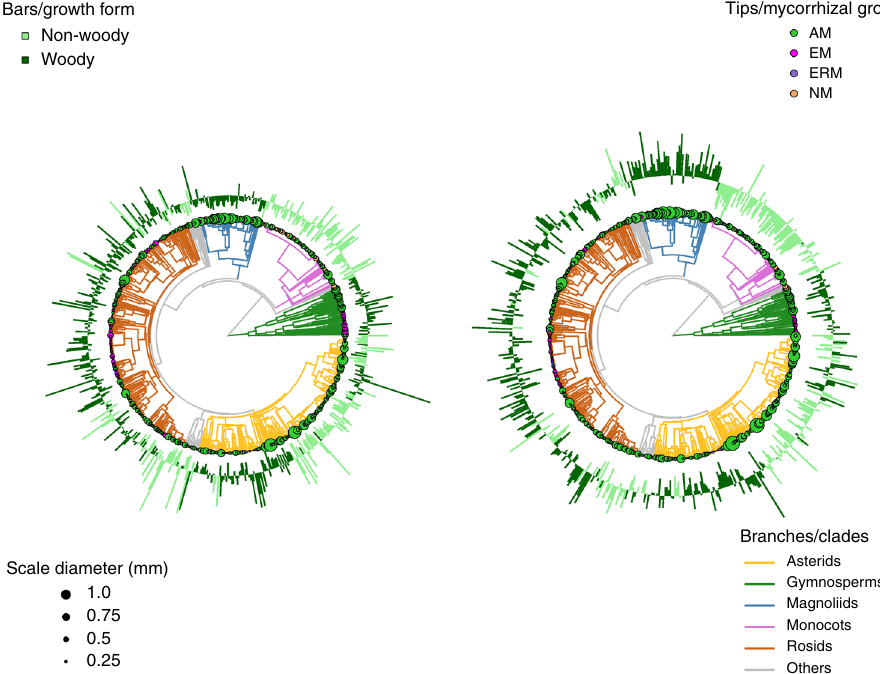
Fig. 3 Variation of root traits with plant phylogeny. Variation in root diameter, root tissue density (RTD, left panel) and root N concentration (RN, right panel) with plant phylogeny, growth form and mycorrhizal type. The size of the circles at the tip of the phylogenetic tree is proportional to root diameter. Bars represent standardized values for RTD and RNC, with outward and inward bars representing values above and below the mean, respectively, and colors representing different growth forms. Branch colors in both phylogenies represent main phylogenetic clades and tips are proportional representations of root diameter colored by different mycorrhizal types: NM = non-mycorrhiza (orange); AM = arbuscular mycorrhizal (green); EM = ectomycorrhizal (magenta); ERM = ericoid mycorrhizal (violet)